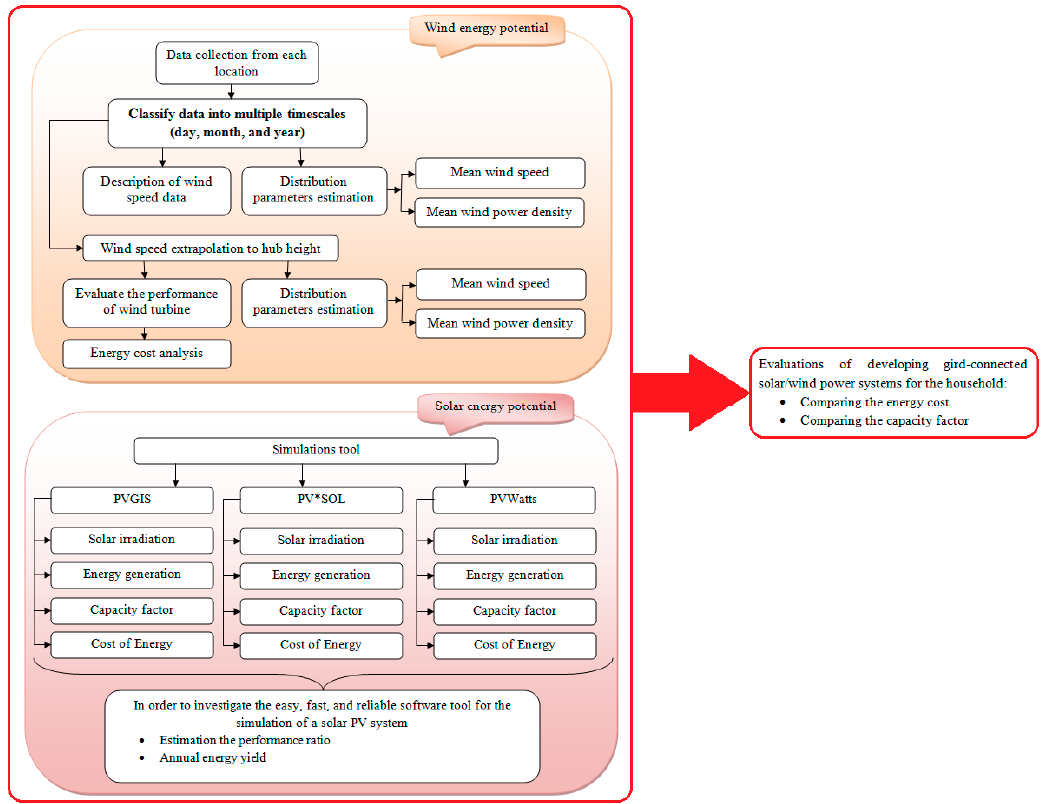
Figure 1. Flowchart of analysis procedure of the present study.